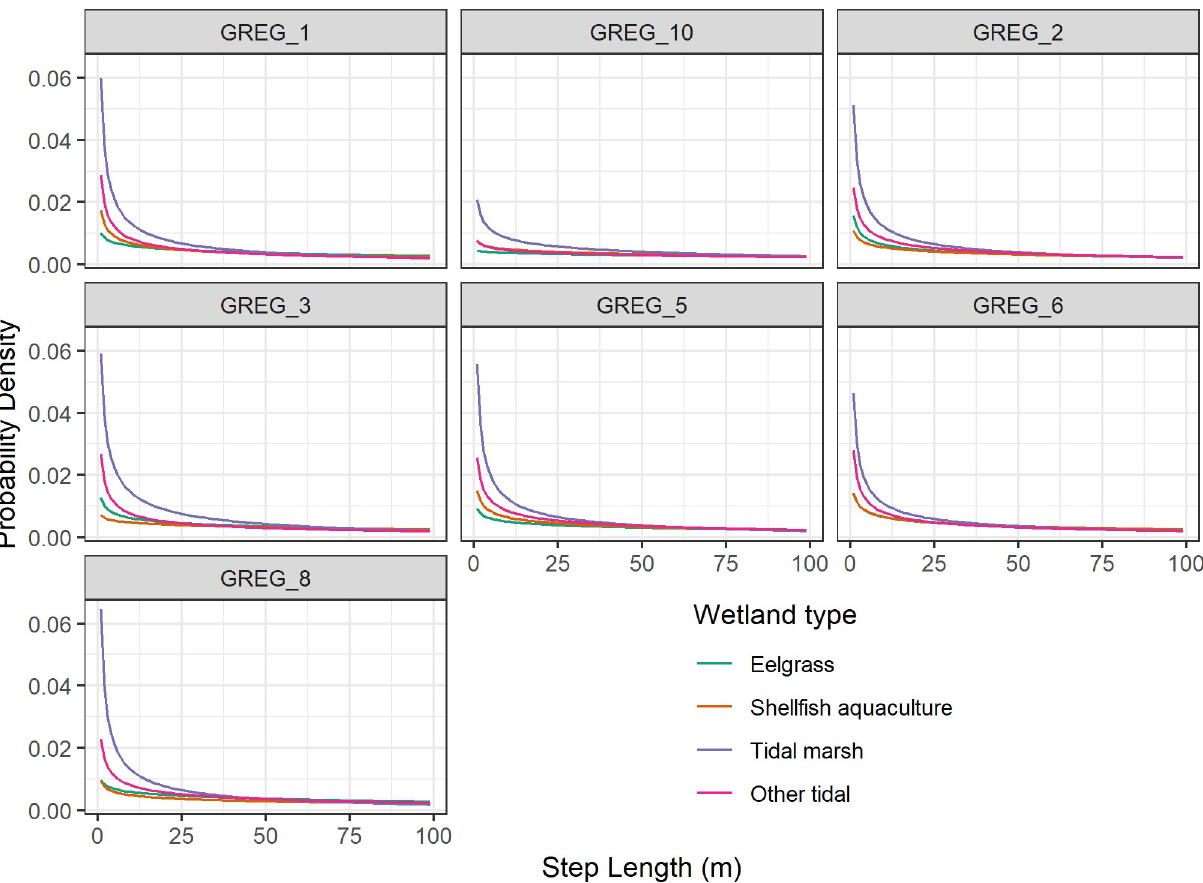
Fig 3. Distribution of step lengths (straight distance between consecutive evenly spaced timestamps) in different tidal wetland types by foraging great egrets at Tomales Bay, CA, 2017–2020. Probability density was calculated for step lengths 0–400 m, but only step lengths where there was visible difference in plotted values among habitats are